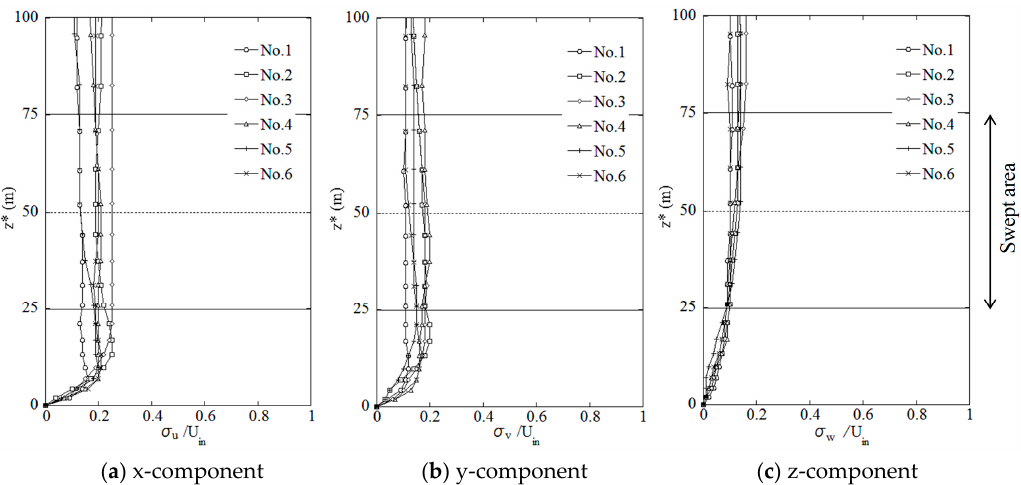
Figure 10. Profiles of instantaneous streamwise wind velocity corresponding to Figure 9 (WT No.3).